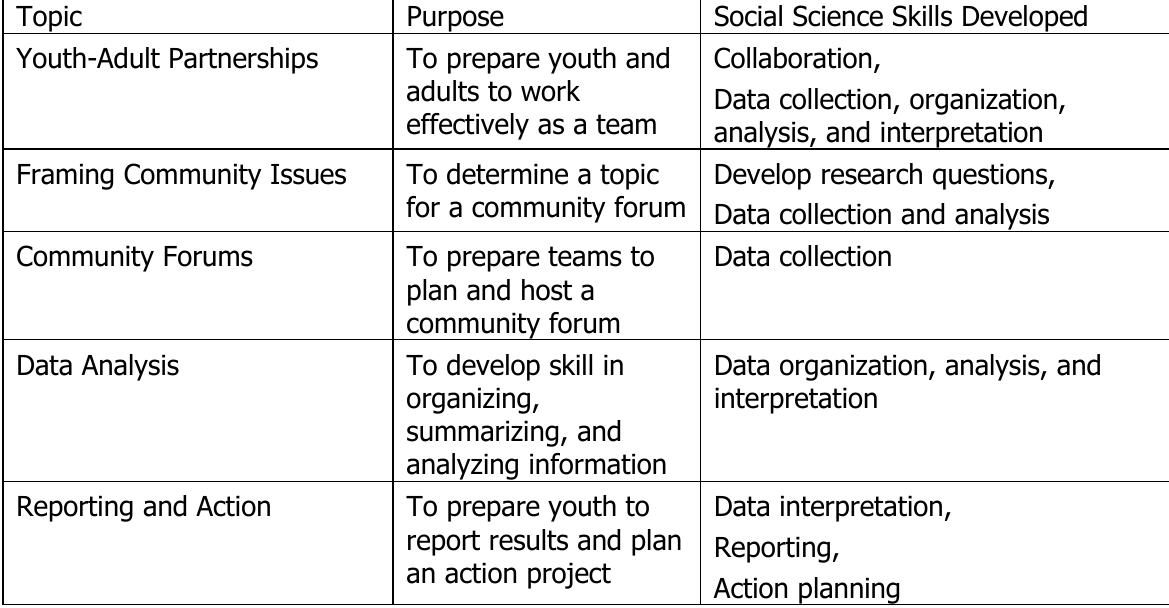
Participatory Evaluation with